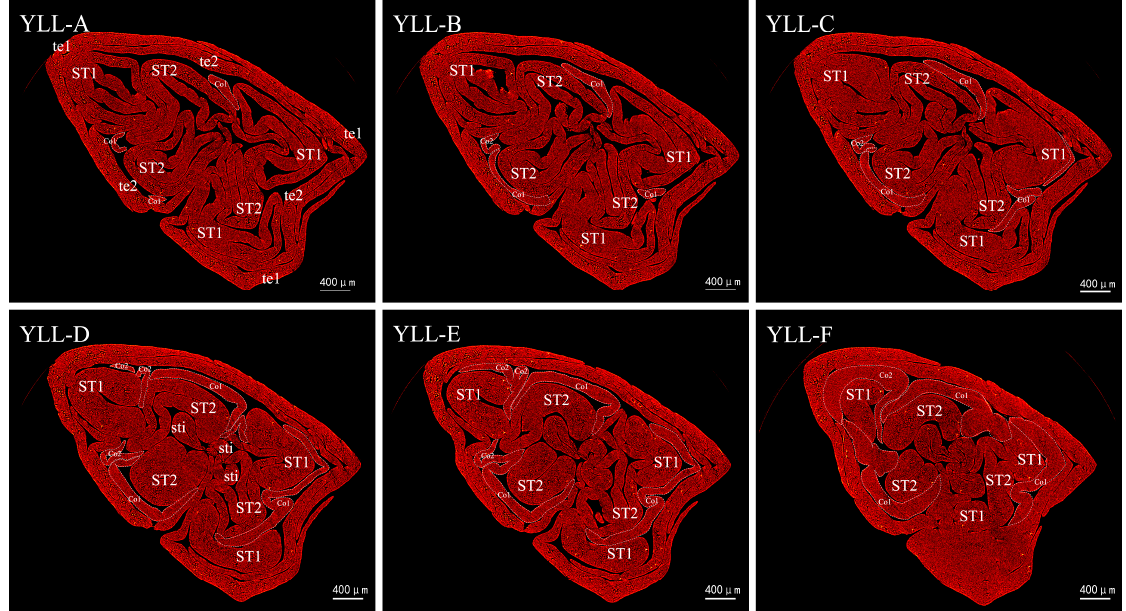
Figure 8. X-ray cross-sectional tomographic images of morphology of the YLL corona. YLL-A to YLL-F are cross-sections from top to bottom in order with the spacings of 46 × 2.1 μ m, 31 × 2.1 μ m, 126 × 2.1 μ m, 95 × 2.1 μ m, and 156 × 2.1 μ m, respectively, where the white dashed circles denote corona primordia in all sections, and ST1 and ST2 denote the first and second whorl of petal-like 126 × 2.1 µ m, 95 × 2.1 µ m, and 156 × 2.1 µ m, respectively, where the white dashed circles stamens, respectively.